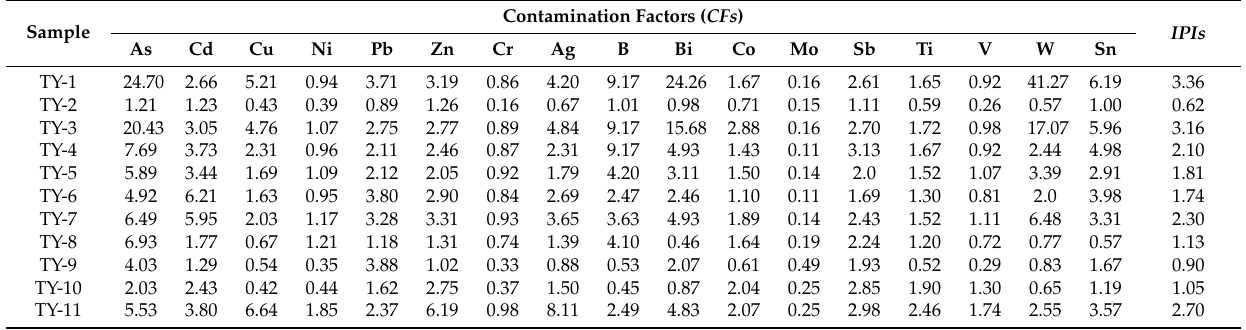
Table 3. Metal contamination factors ( CFs ) and pollution load indexes ( IPIs ) for metals in top soils from the study area.